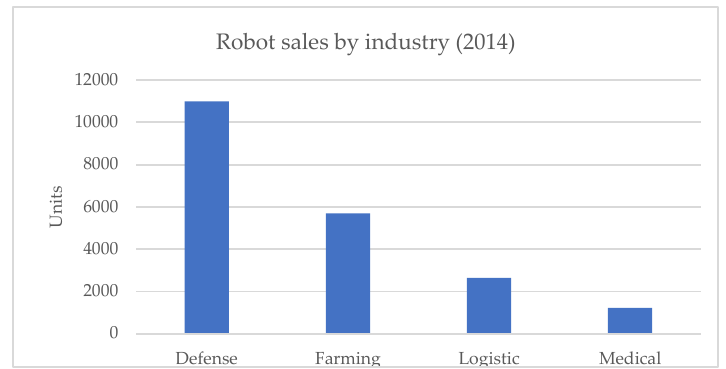
Figure 1. Service robots per industry, for the year 2014. data was obtained from the executive summary of world robotics 2015 [4] .